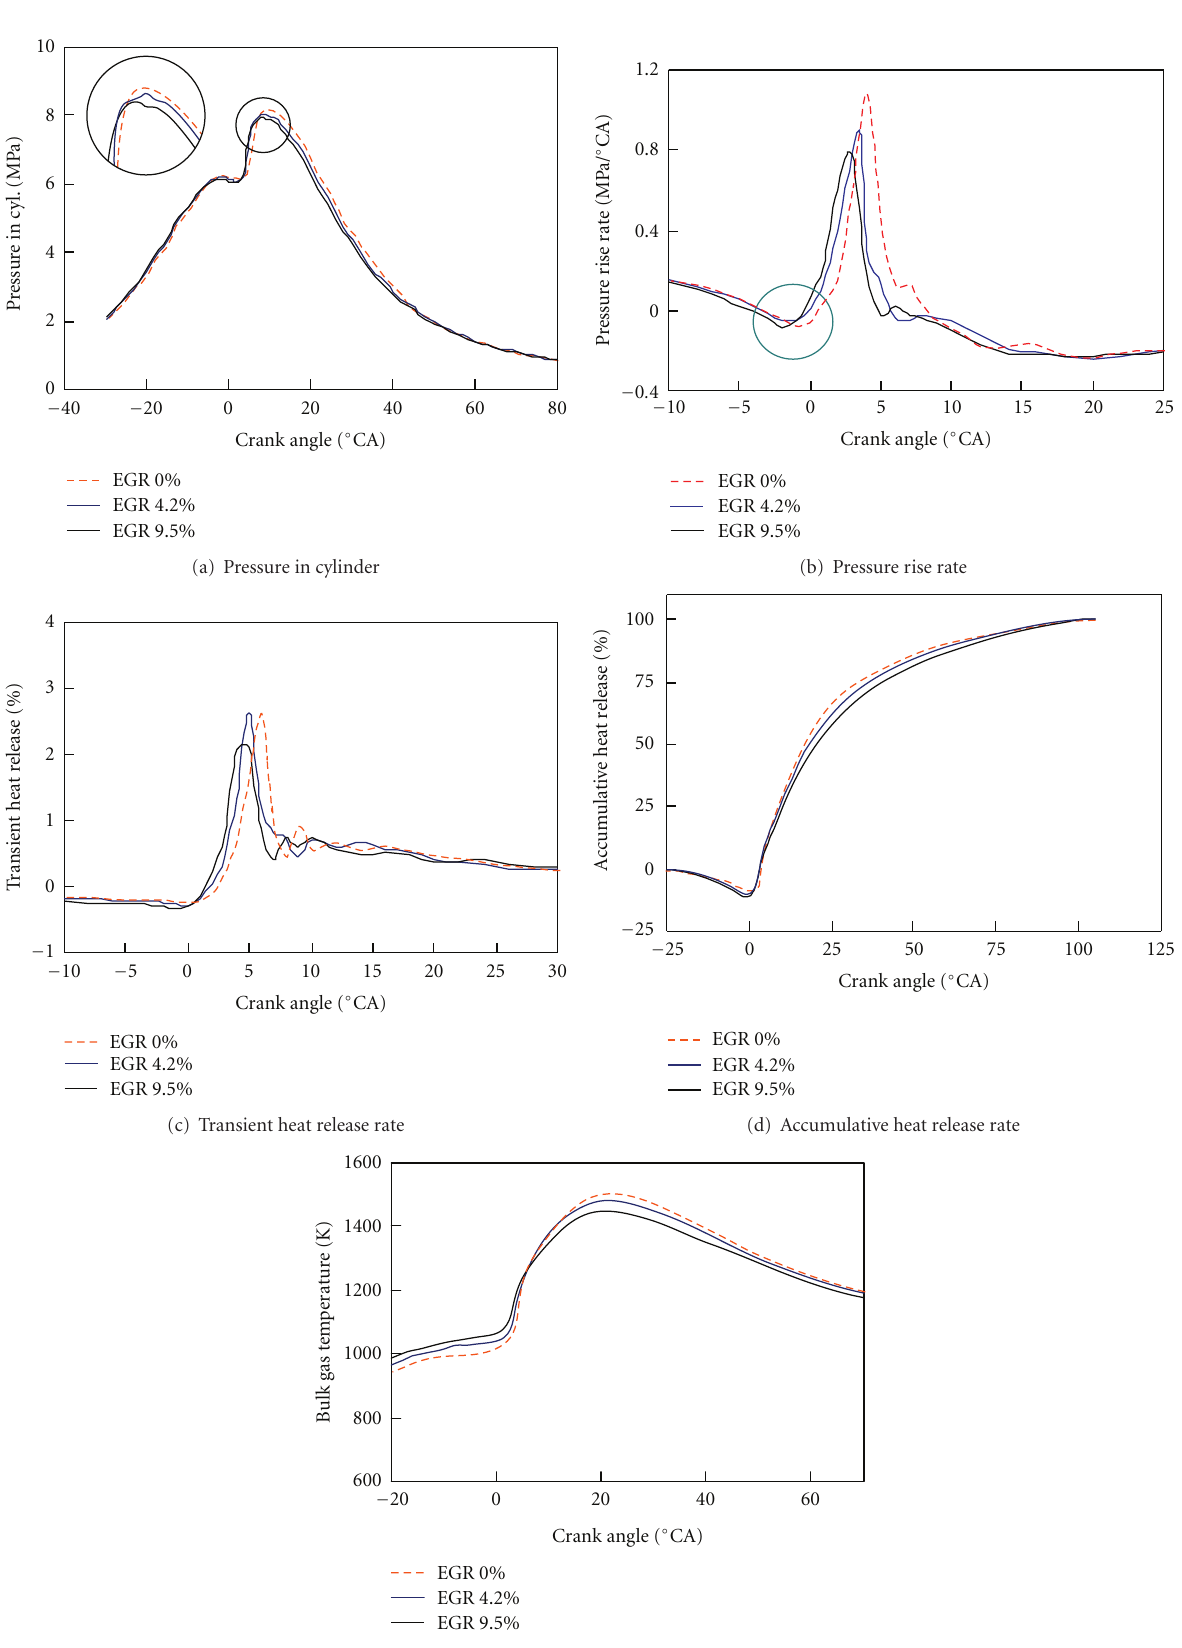
Figure 4: The combustion characteristic parameters of diesel engine with